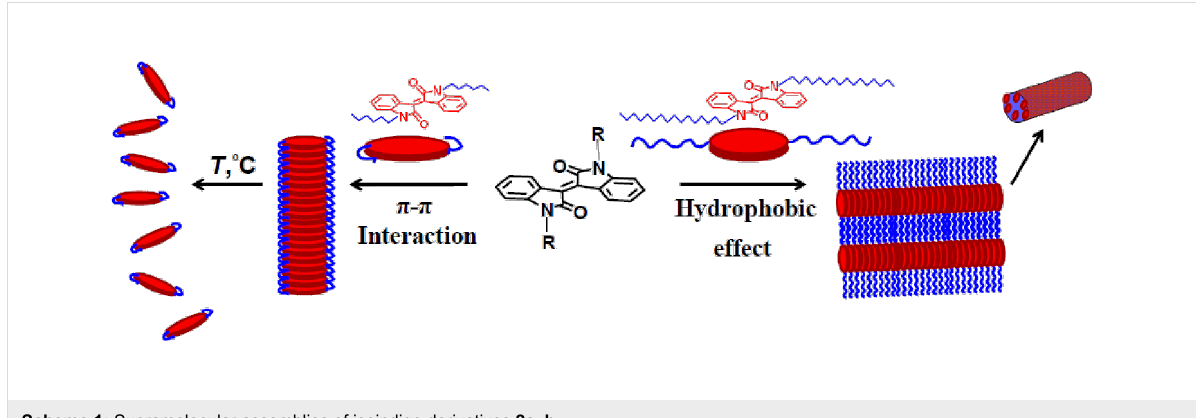
Scheme 1: Supramolecular assemblies of isoindigo derivatives 2a–h